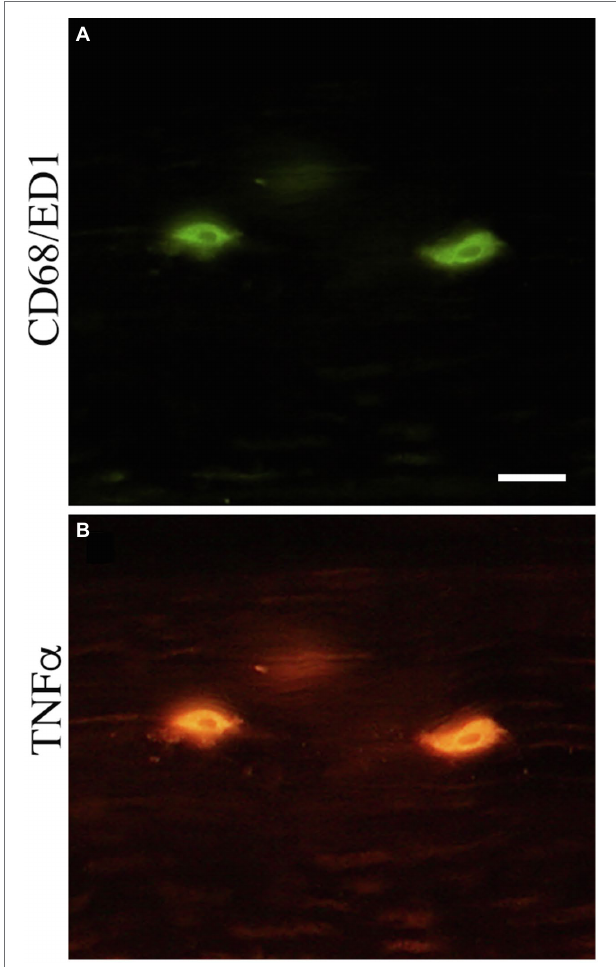
FIGURE 6 | CD68-immunopositive cells double-labeled with tumor necrosis factor alpha (TNF α ) in the median nerve at wrist level. (A) CD68- immunopositive cells (green). (B) TNF α immunopositive cells (red). Scale bar = 50 μ m.